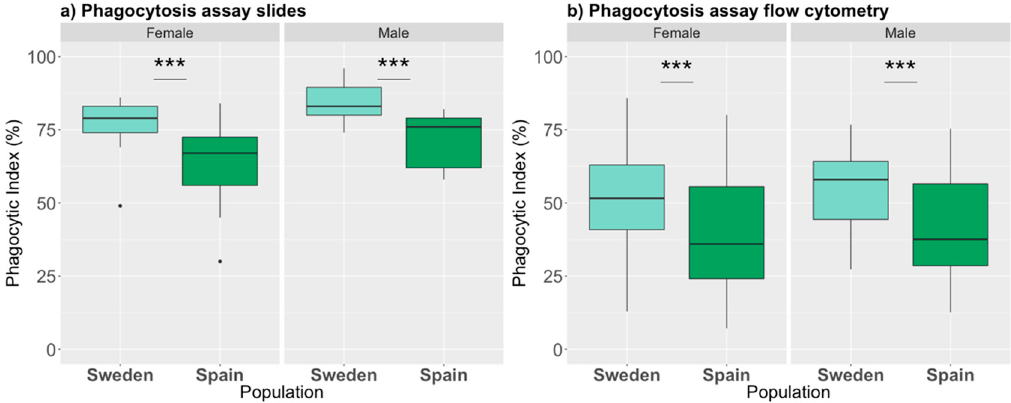
Figure 4. Proportion of phagocytes in P. napi larvae using two different assays. Phagocytic index ( a ) after injection of heat-killed E. coli , calculated via imaging ( N = 44), and ( b ) after exposure to pHrodo-conjugated E. coli, detected by flow cytometry ( N = 122). Bar plots are as described previously. Asterisks denote significance (*: P ≤ 0.05; **: P ≤ 0.01; ***: P ≤ 0.001); note that for the phagocytosis slides males and females also significantly differed.